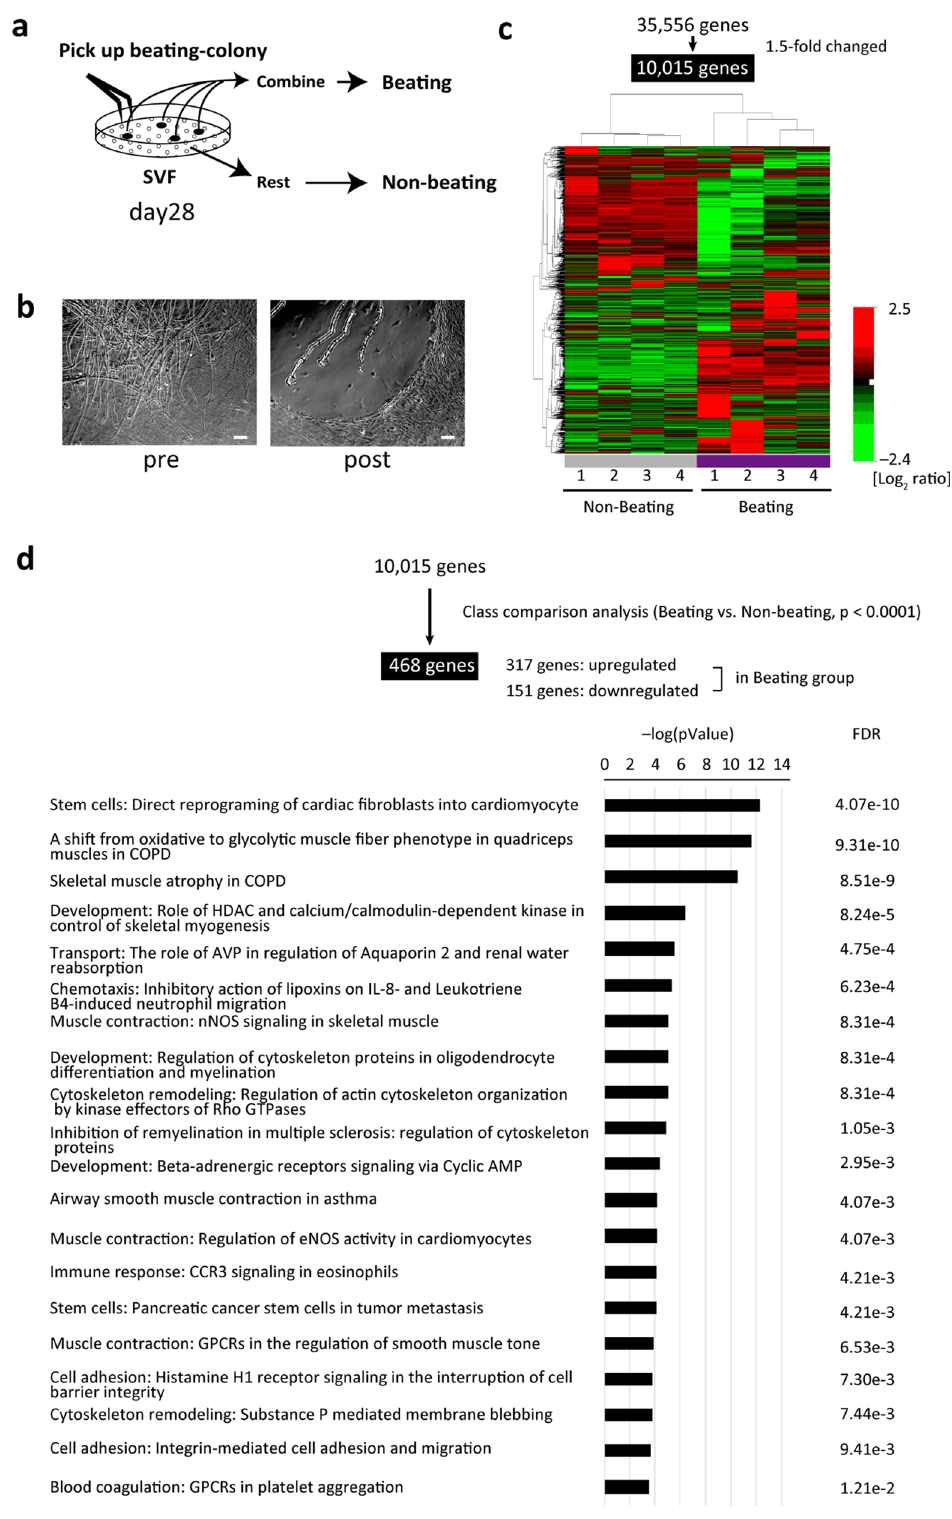
Figure 2. Global transcriptome analysis of SVF beating cell clusters. ( a ) Schematic of RNA extraction from beating (beat) and non- beating (non-beat) cells. ( b ) Phase-contrast images of a beating cell cluster before (pre) and after (post) being picked-up. Scale bar, 100 µm. ( c ) Heatmap image of microarray data clustered using an unsupervised learning method, showing DEGs between beating and non-beating SVF cells using 10,015 prefiltered genes (under the condition that at least one expression value is at least 1.5-fold changed in either direction from the median value; n = 4 per group). The scale extends from 0.19- to 5.7-fold over the median (–2.4 to + 2.5 on a log 2 scale). Red indicates increased expression, whereas green indicates decreased expression. The graphical image of heatmap was generated using BRB Array Tools software (v. 4.6.0) (NIH, Bethesda, MD, USA) (URL: https ://brb.nci.nih.gov/BRB-Array Tools /). ( d ) Gene pathways altered in the beating group among 468 genes extracted by class comparison analysis ( p < 0.0001) from 10,015 prefiltered genes (FDR: 10 −7 to 0.002). FDR, false discovery